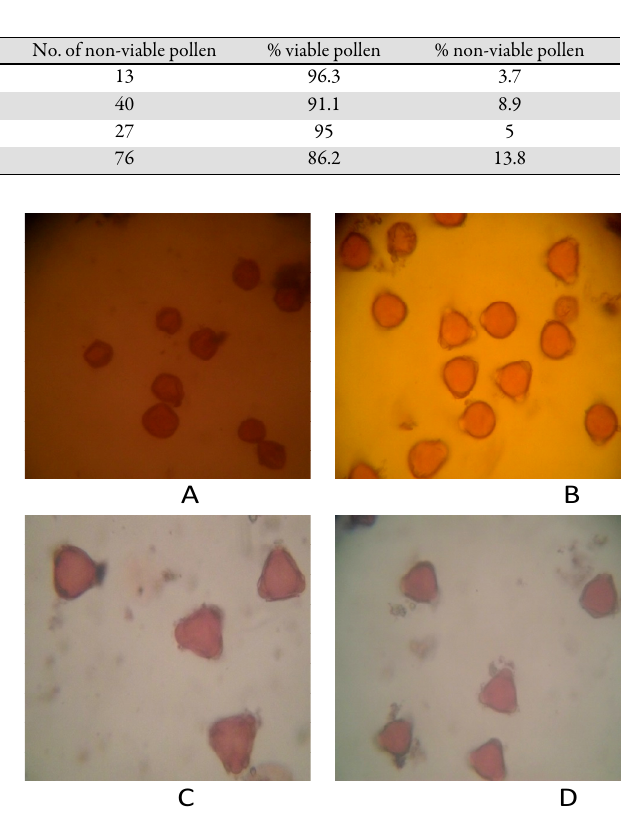
Fig. 1. Variation in pollen viability, size and shape in the studied pepper varieties. A- C. annuum var. abbreviatum ; B- C. annuum var. acuminatum ; C- C. annuum var. grossum ; D -C. frutescens var. baccatum . MG X